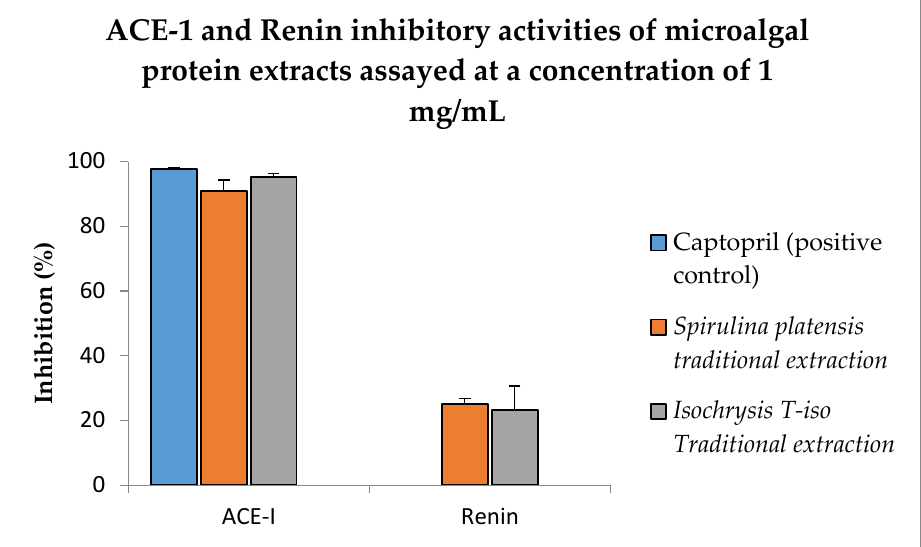
Figure 6. ACE-I and renin inhibitory activities of proteins extracted from Spirulina sp. and Isochrysis galbana T-Iso , assayed at a concentration of 1 mg/mL compared with the control (Captopril©) (n = 3) and 10 µM Z-Arg-Arg-Pro-Phe-His-Sta-Ile-His-Lys-(Boc)-OMe (renin inhibitor).